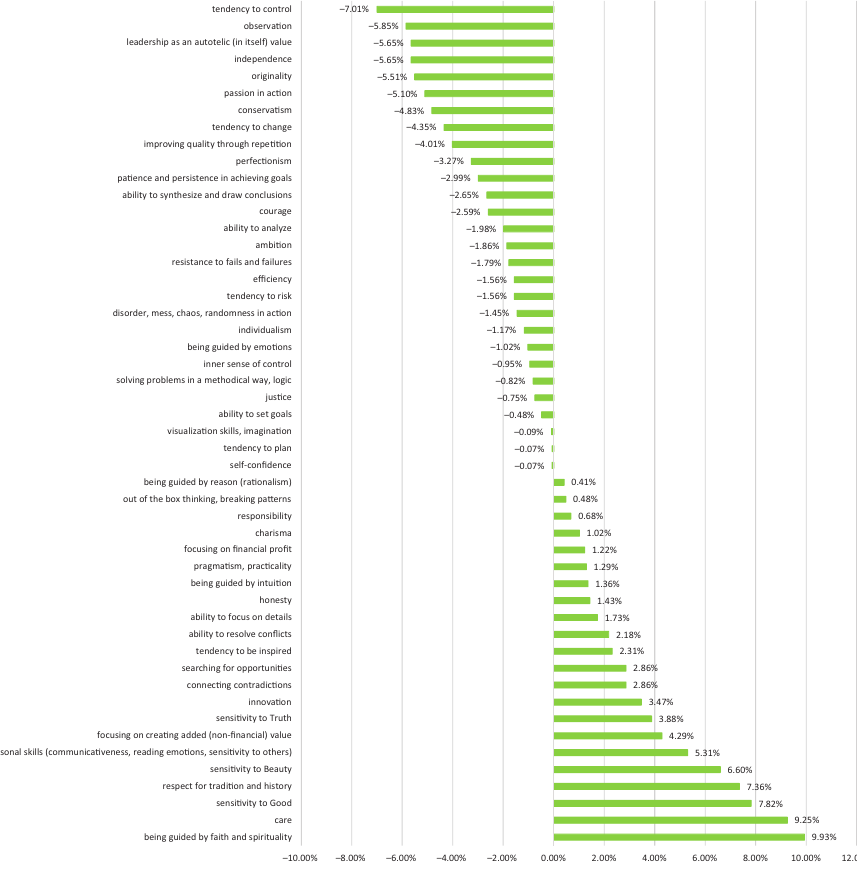
Figure 11. Perception of the 50 features of a manager’s identity by artistic versus non-artistic indi- viduals (source: created by